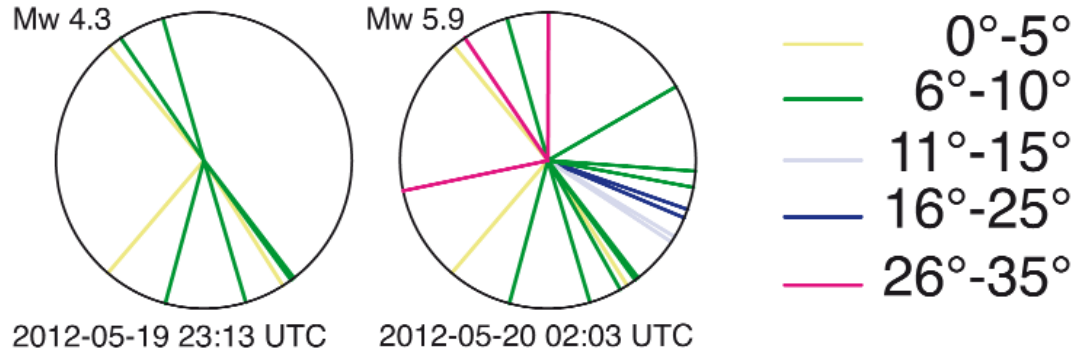
4.1 and May 20, 2012, M 5.9 events, to compare the station distribution and L L